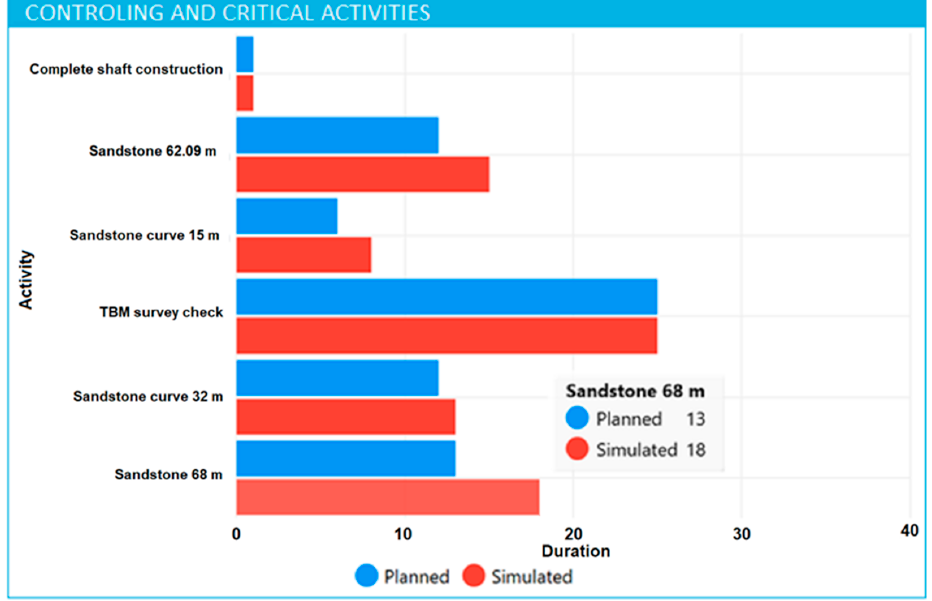
Figure 8. Illustration of the controlling activities of the tunneling segment.